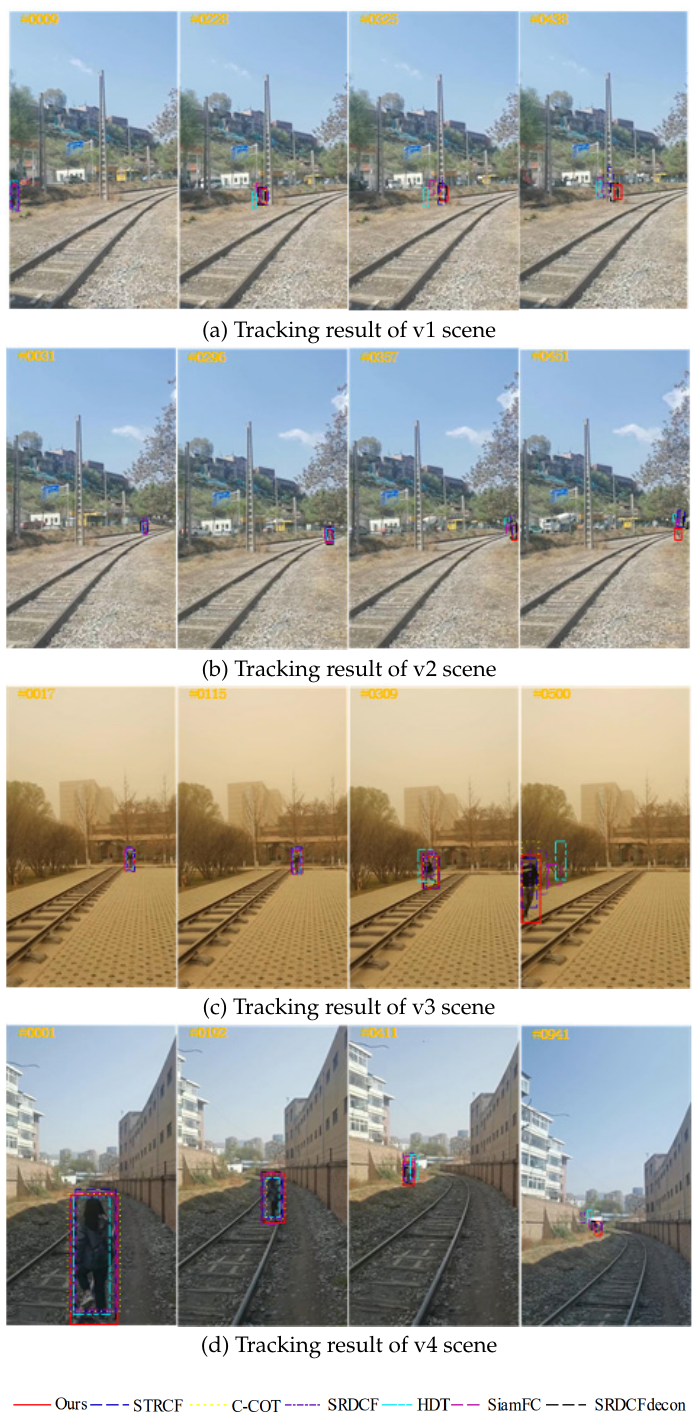
Fig. 6. Comparison of tracking results of different algorithms in v1 ∼